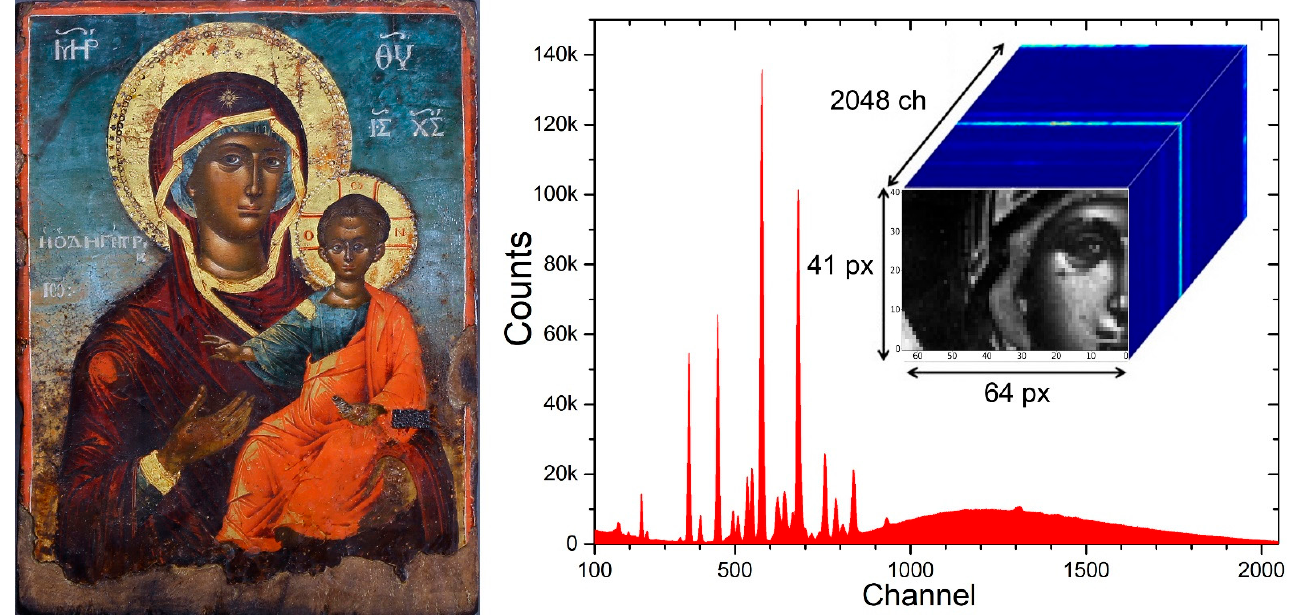
Figure 1. Left: Virgin Mary “Odigitria”, 18th century. Right: Sum of the 2665 XRF spectra acquired during the current scanning. Inset: the analyzed area. Every single spectrum and its (x, y) spatial position define a pixel.